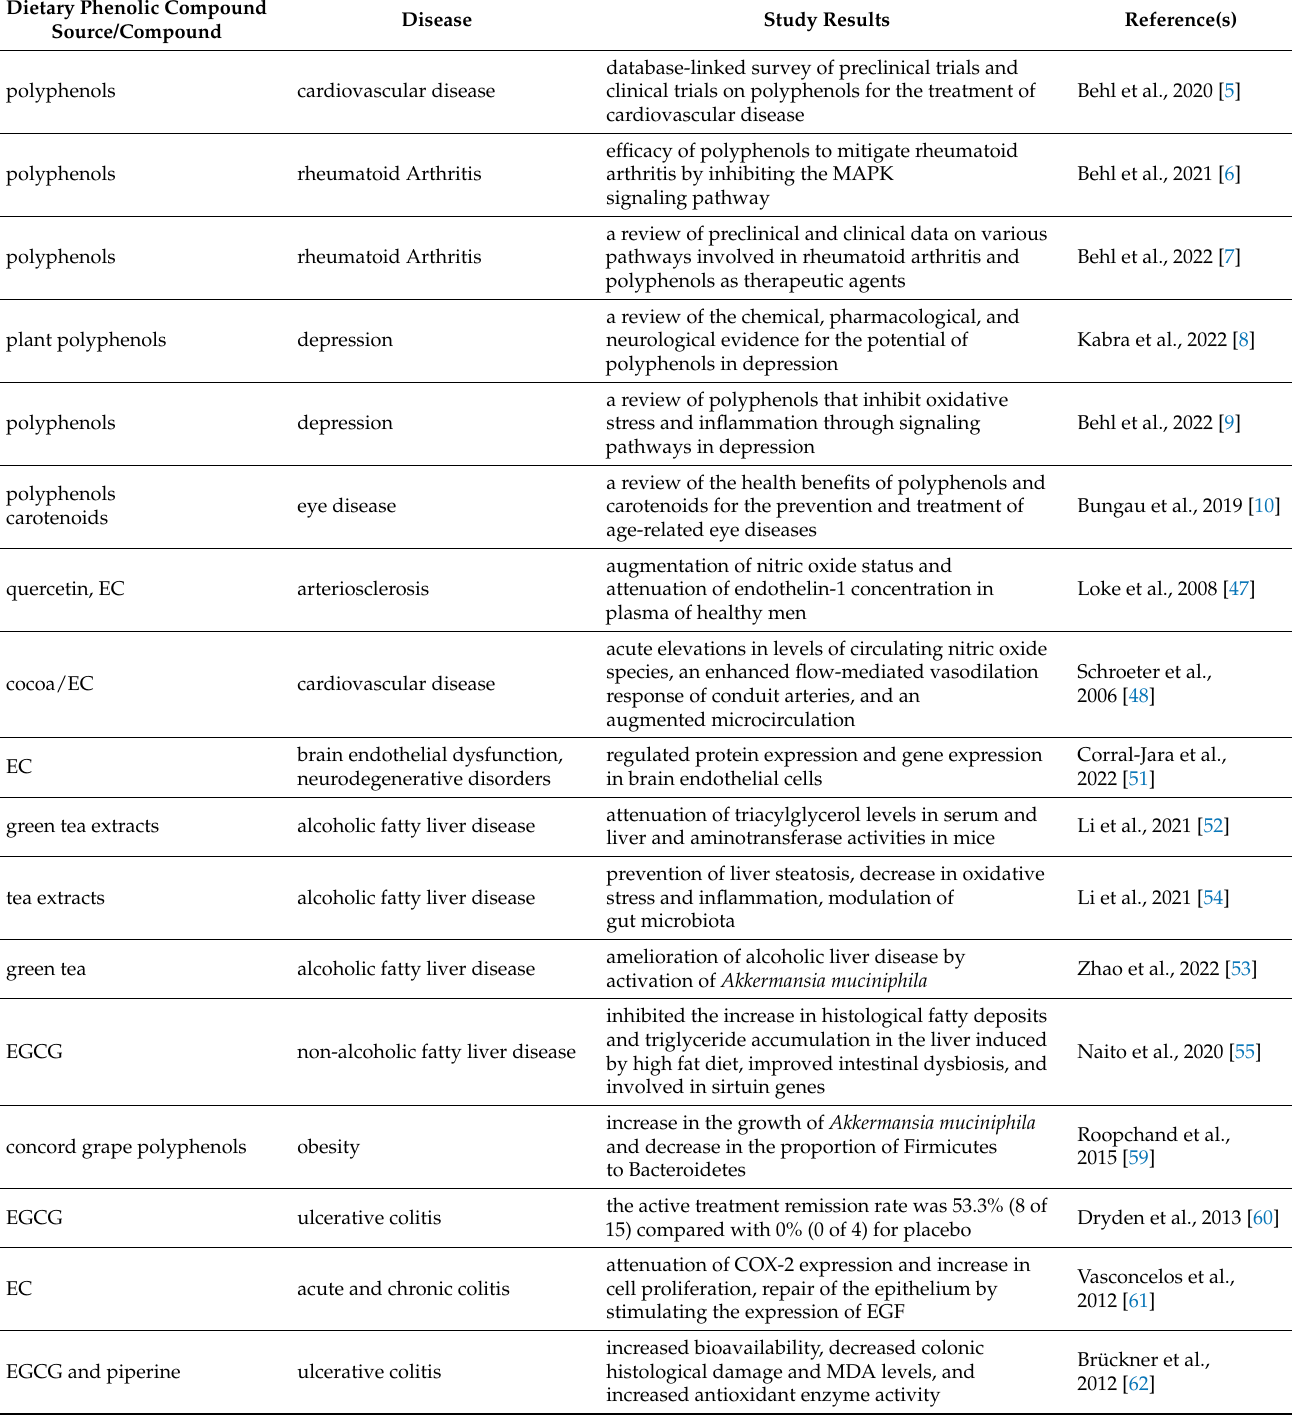
Table 1. Salutary effects of phenolic